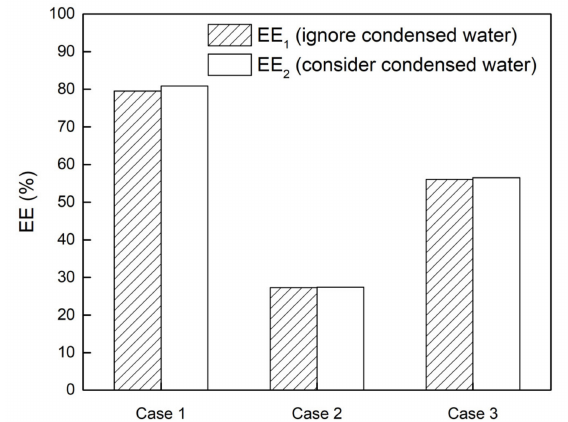
Figure 4. Flue gas waste heat exergy efficiencies of three cases.